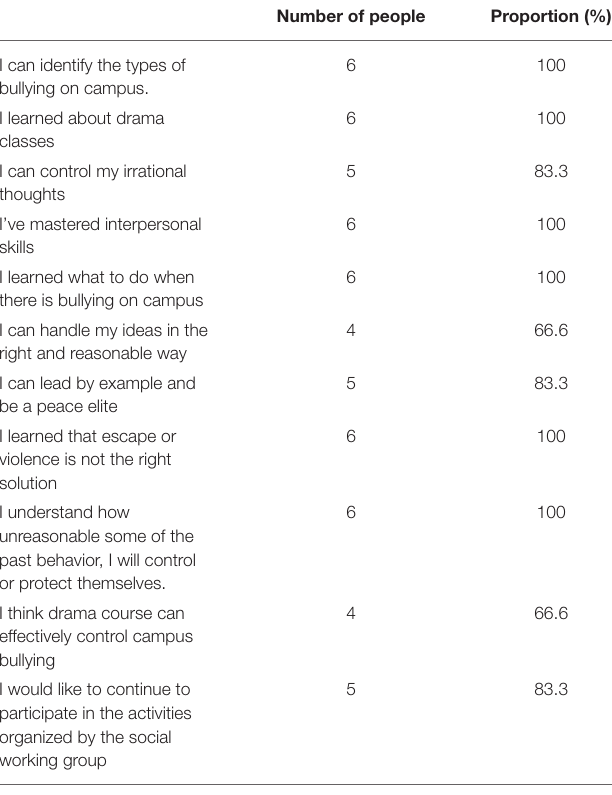
TABLE 9 | Drama course effect self—scaletitle.